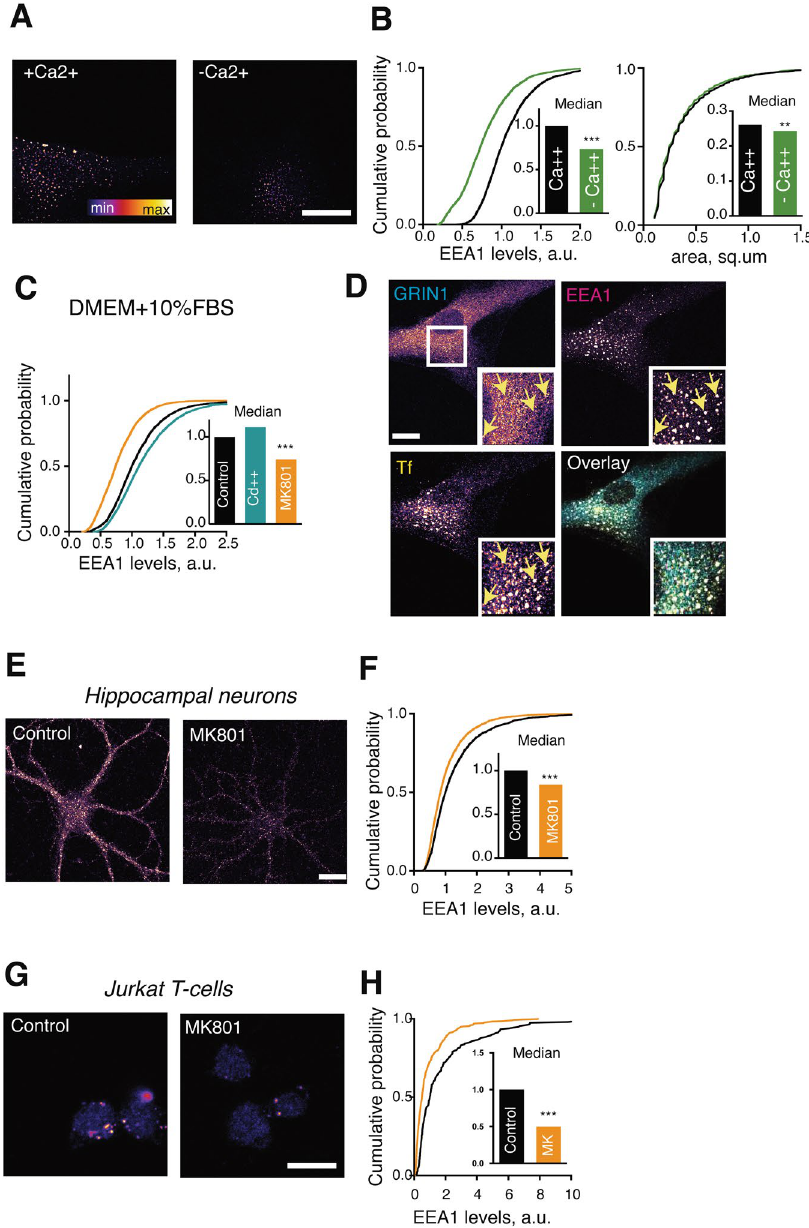
Figure 1. Ca 2 + influx through NMDARs rapidly regulates EEs. ( A ) Representative image of primary human fibroblasts incubated for 10 min in PBS or PBS supplemented with 1.8 mM CaCl 2 . ( B ) Left, quantification of EEA1 immunostaining levels in cells incubated in PBS with or without added CaCl2. Right, quantification of the EEA1 area in cells incubated in PBS with or without added CaCl 2 . N = 50–250 EEs/image, 20 images/ condition, 4 independent experiments. ( C ) Quantification of the EEA1 immunostaining levels in cells following incubation for 10 min in DMEM + 10% FBS in presence of indicated drugs. N = 50–250 EEs/image, 25 images/ condition, 5 independent experiments. ( D ) Immunostaining for endogenous GRIN1 in fibroblasts. Live cells were incubated with fluorescent Transferrin (Tf) for 1 h at 37 °C, fixed and immunostained for GRIN1 and EEA1. Arrows denote GRIN1 signal colocalising with EEA1- and Tf-positive puncta. ( E ) Dissociated rat hippocampal neurons (21 days in vitro ) were treated with MK801 for 30 min at 37 °C. ( F ) Quantification of the EEA1 immunostaining levels in neurons treated with MK801. N = 20–100 EEs/image, 15 images/condition, 3 independent experiments. *** P < 0.0001, ** P < 0.01, Mann-Whitney U test. Scale bar, 20 μ m. ( G ) Jurkat T cells were treated with MK801 for 30 min at 37 °C. ( H ) Quantification of the EEA1 immunostaining levels in Jurkat T cells treated with MK801. N = 20–100 EEs/image, 3–5 images/condition, 2 independent experiments. *** P < 0.0001, Mann-Whitney U test. Scale bar, 20 μ